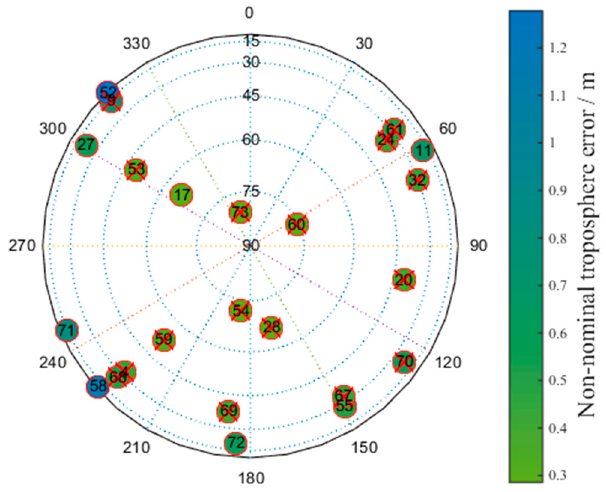
Figure 20. Skyplot of the optimal satellite subset obtained by the greedy method.